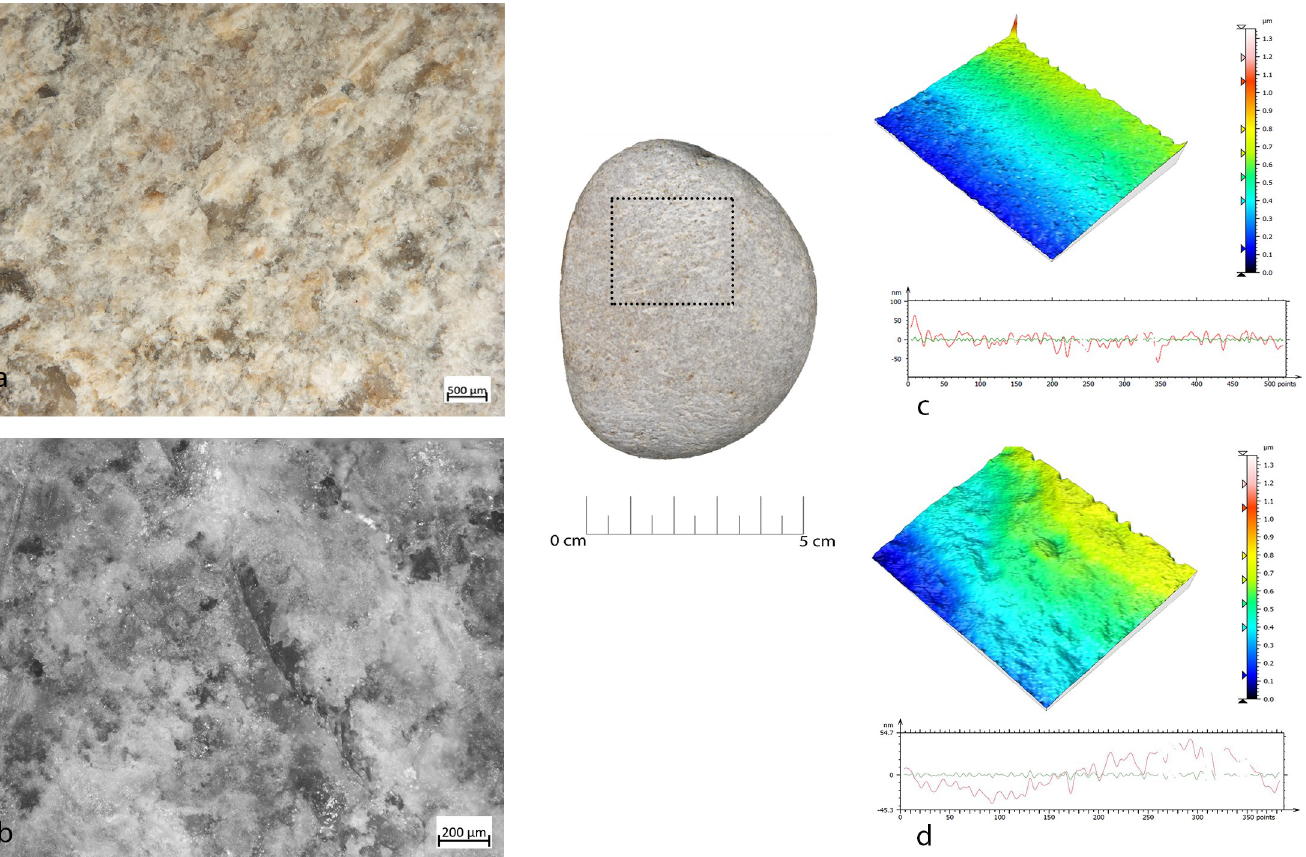
Fig 10. FRS-1 use wear on experimental replica used in scaled retouch. (a) Macro-traces (30x), contiguous pits of linear form (half-moon), with rough bottom, and triangular section; the traces are located in the centre of the apical area; (b) polishes (200x) are absent; (c) 3D microtopography of the unused surface and profile; (d) 3D microtopography of the used surface and